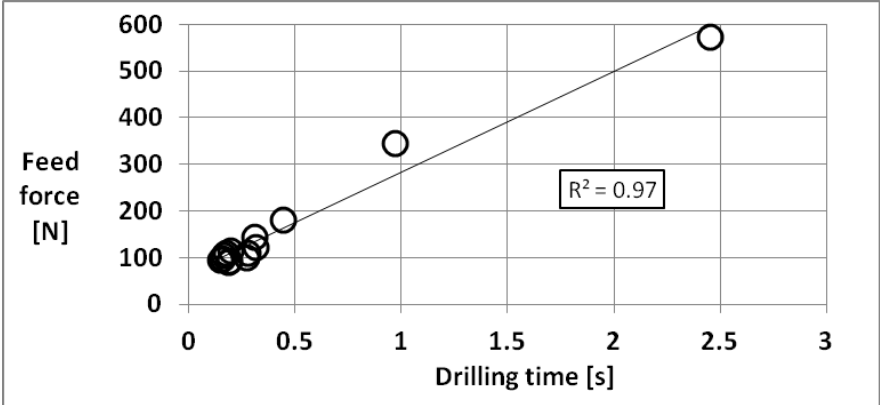
Figure 7. The relationship between the averaged time needed to make a 10 mm deep hole (drilling time) and the averaged feed forces, measured during the earlier, significantly reliable machinability testing [12] for all fourteen tested